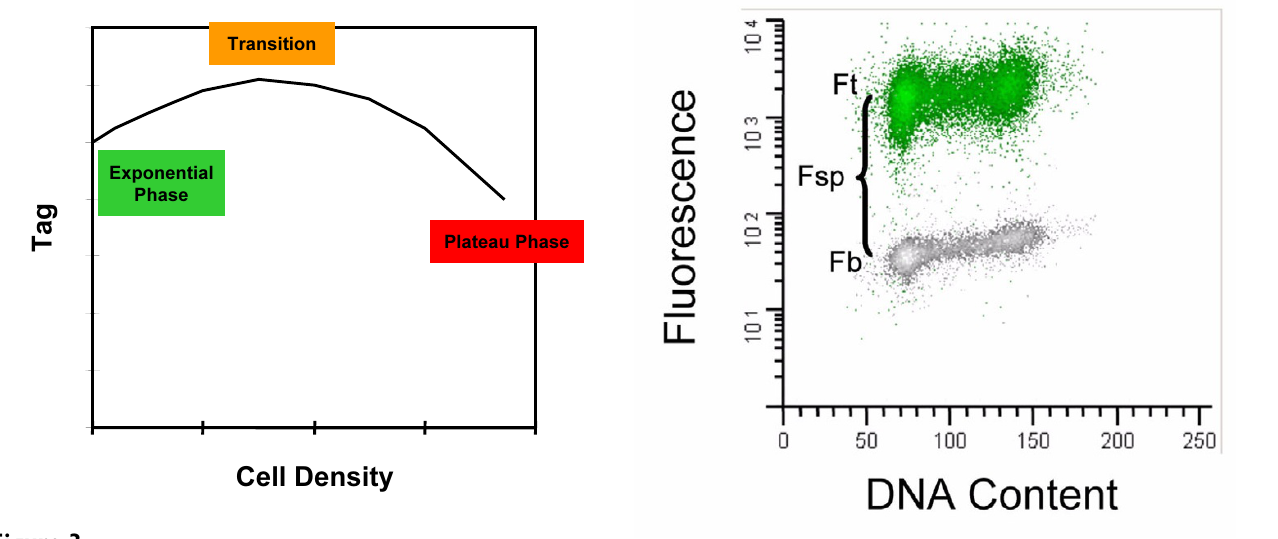
Figure 4 Flow cytometry measurements of Tag and DNA. This is an example of the cytometric data collected for this study. P0-3D tkT#5 cells were immunofluorescently labeled with PAB 416 (anti-Tag) or IgG2a (isotype control) and FITC-con- jugated goat anti-mouse secondary antibody. DNA was stained with propidium diiodide. Mean linear immunofluores- cence of the G 1 sub-population for the isotype control (Fb) was subtracted from that of the Tag-stained sample (Ft) to generate the measurement of Tag expression